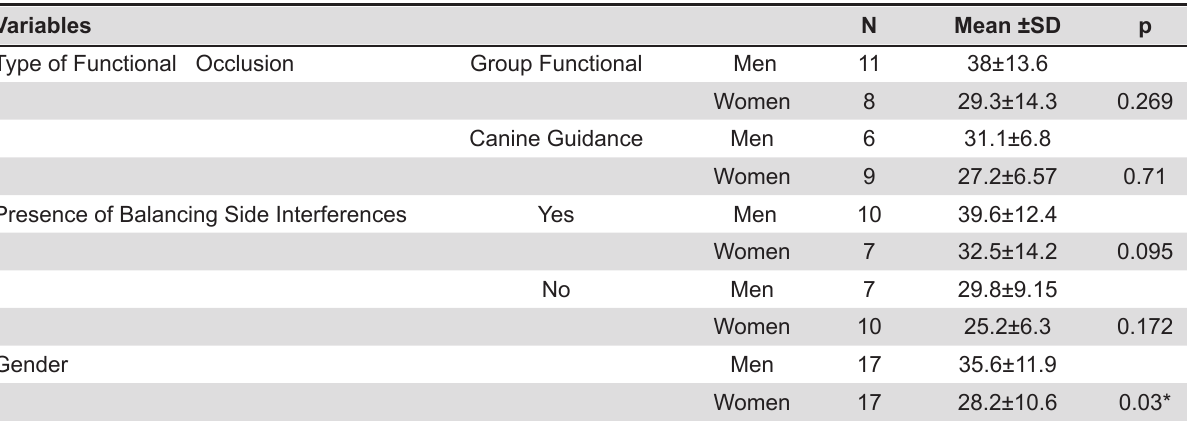
Table 2- Means ± standart deviations (SD) of maximum bite force and p values in subjects according to type of functional occlusion, presence of balancing side interferences and gender (*means